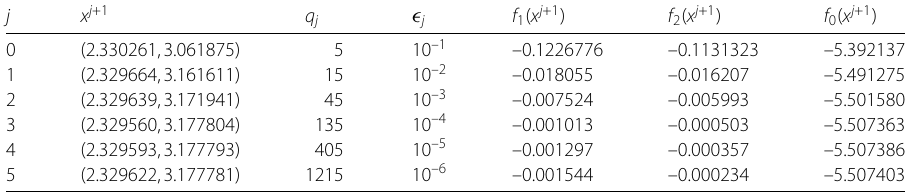
Table 8 Numerical results for Example 4.3 with x 0 = (1.0,1.5)